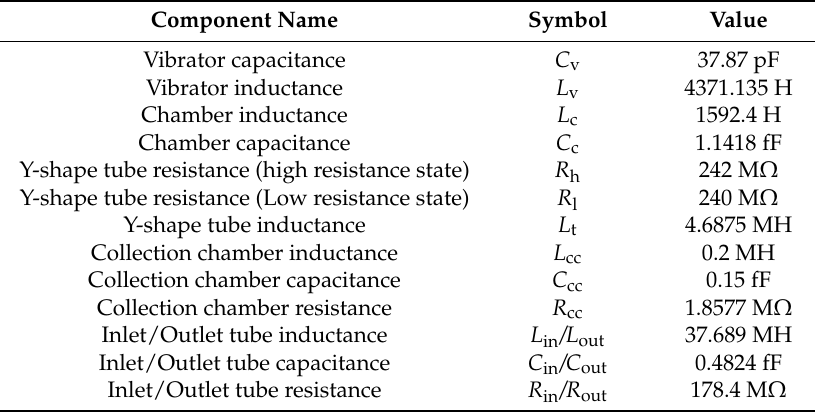
Figure 9. Curves of mass flow versus pressure drop. Table 2. Calculation results for equivalent circuit components.